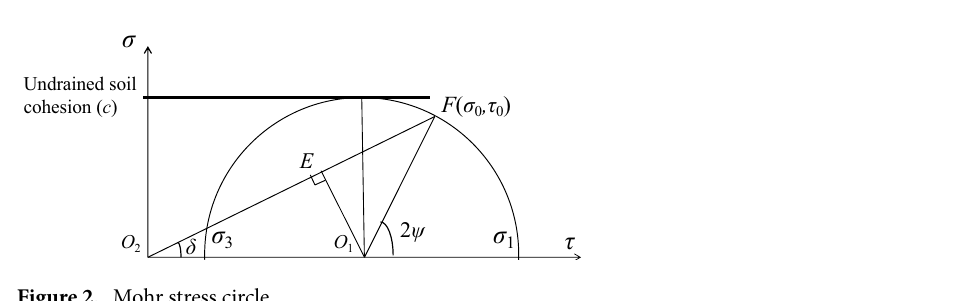
Figure 2. Mohr stress